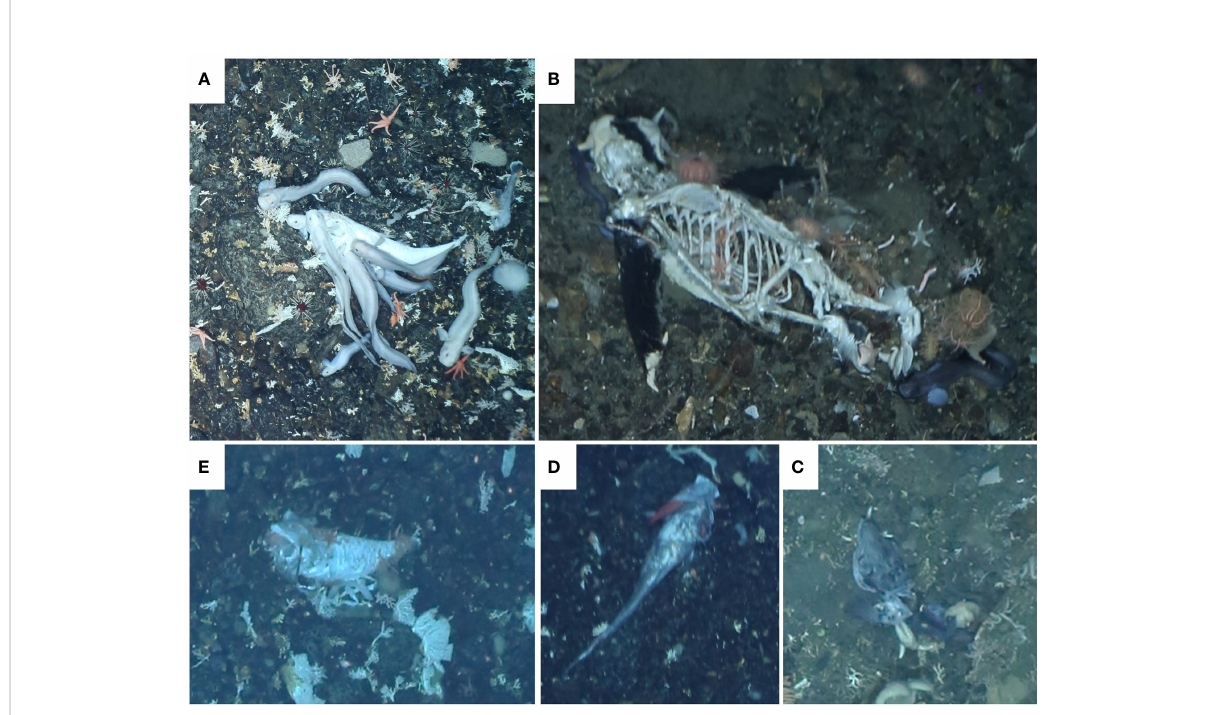
FIGURE 2 Medium-sized food falls and associated scavengers detected on the slopes of the Powell Basin during cruise PS118. (A) Fish carcass ( ” Fish_3 ” ) at 2112 m scavenged by zoarcid fi sh. (B) Penguin carcass found at 613 m accompanied by echinoderms and zoarcid fi sh. (C) Fish carcass ( “ Fish_4 ” ) at 647 m. (D) Fish remains ( “ Fish_2 ” ) found at 2165 m with scavenging amphipod burrowed into its gill slit. (E) Fish carcass ( “ Fish_1 ” ) from 2136 m. Images were cropped and light correction was applied if